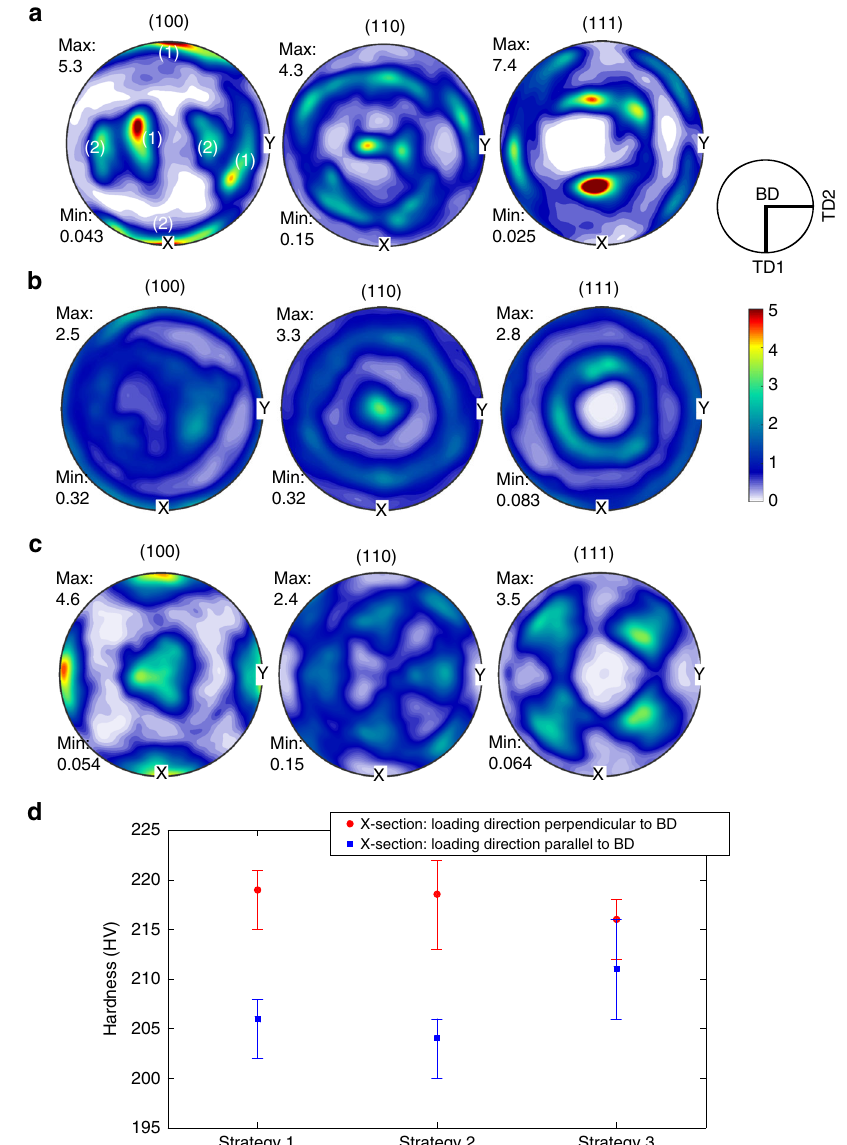
X-section: loading direction perpendicular to BD X-section: loading direction parallel to BD